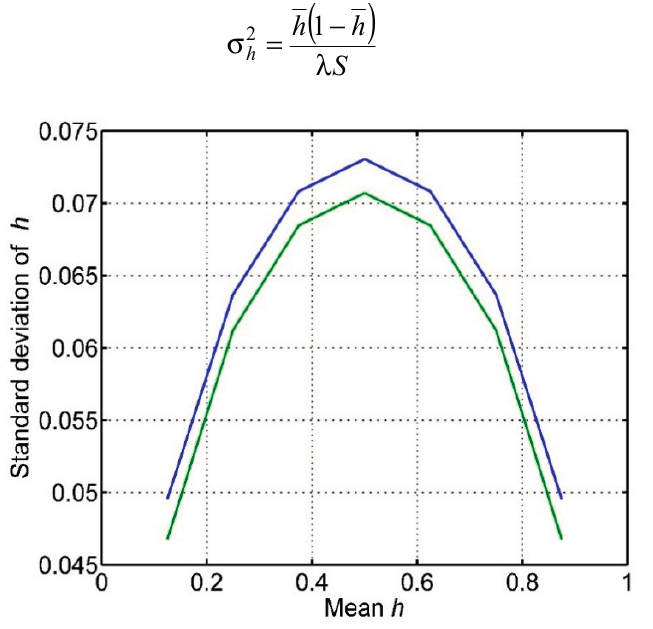
Figure 16. The standard deviation for hit success rate h for the values of h plotted in Figure 15 (blue line). Also shown is the theoretical standard deviation from Equation (18) (green